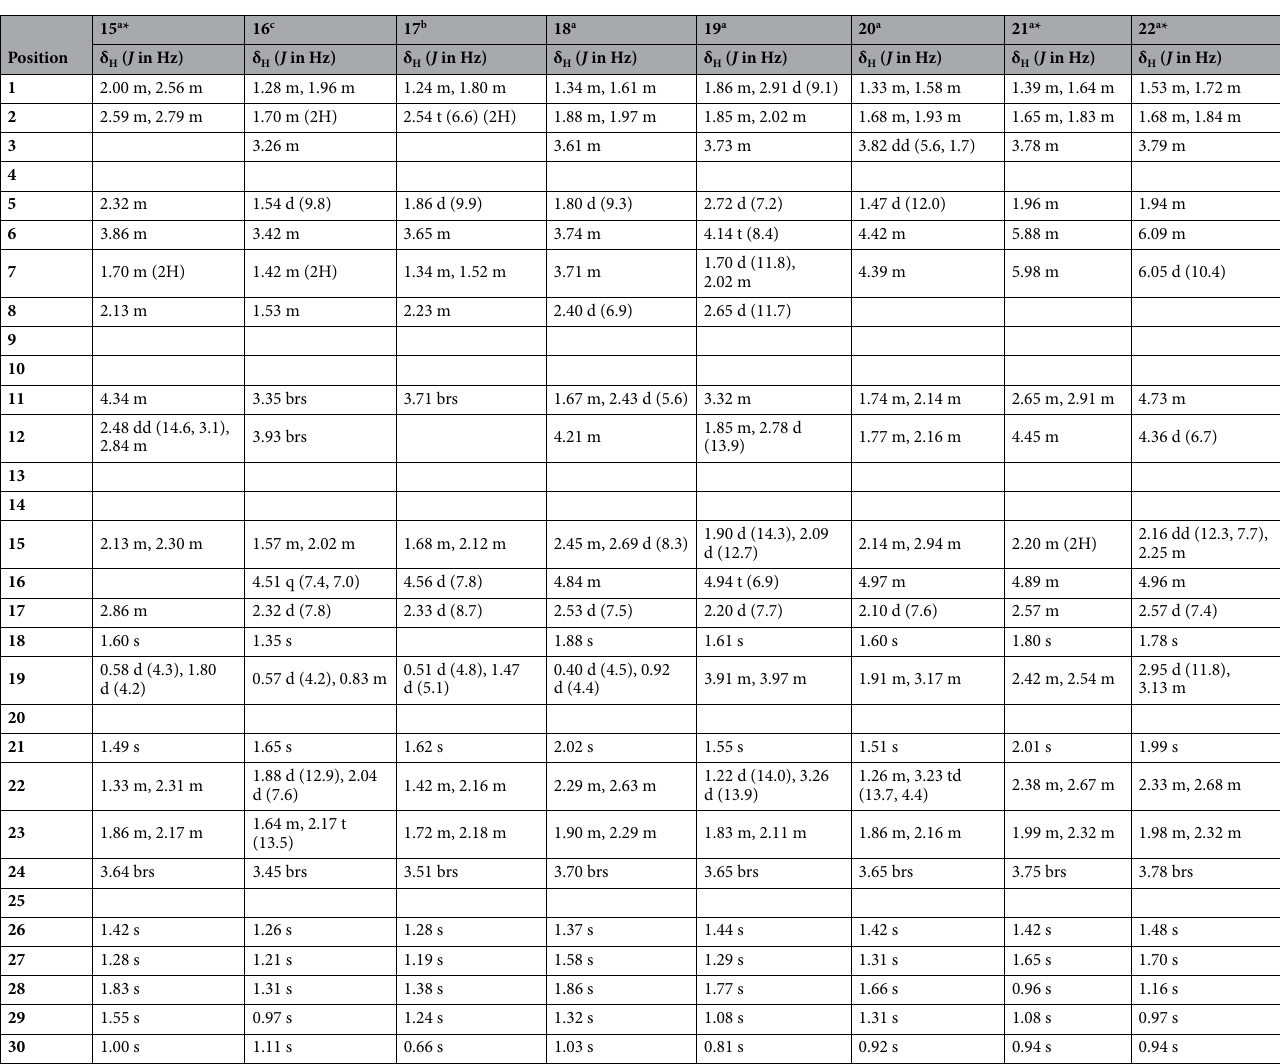
Table 4. 1 H NMR spectroscopic data of compounds 15 – 22 (400 MHz and *500 MHz). a In C 5 D 5 N. b In CDCl 3 . c In CD 3 OD and a drop of C 5 D 5